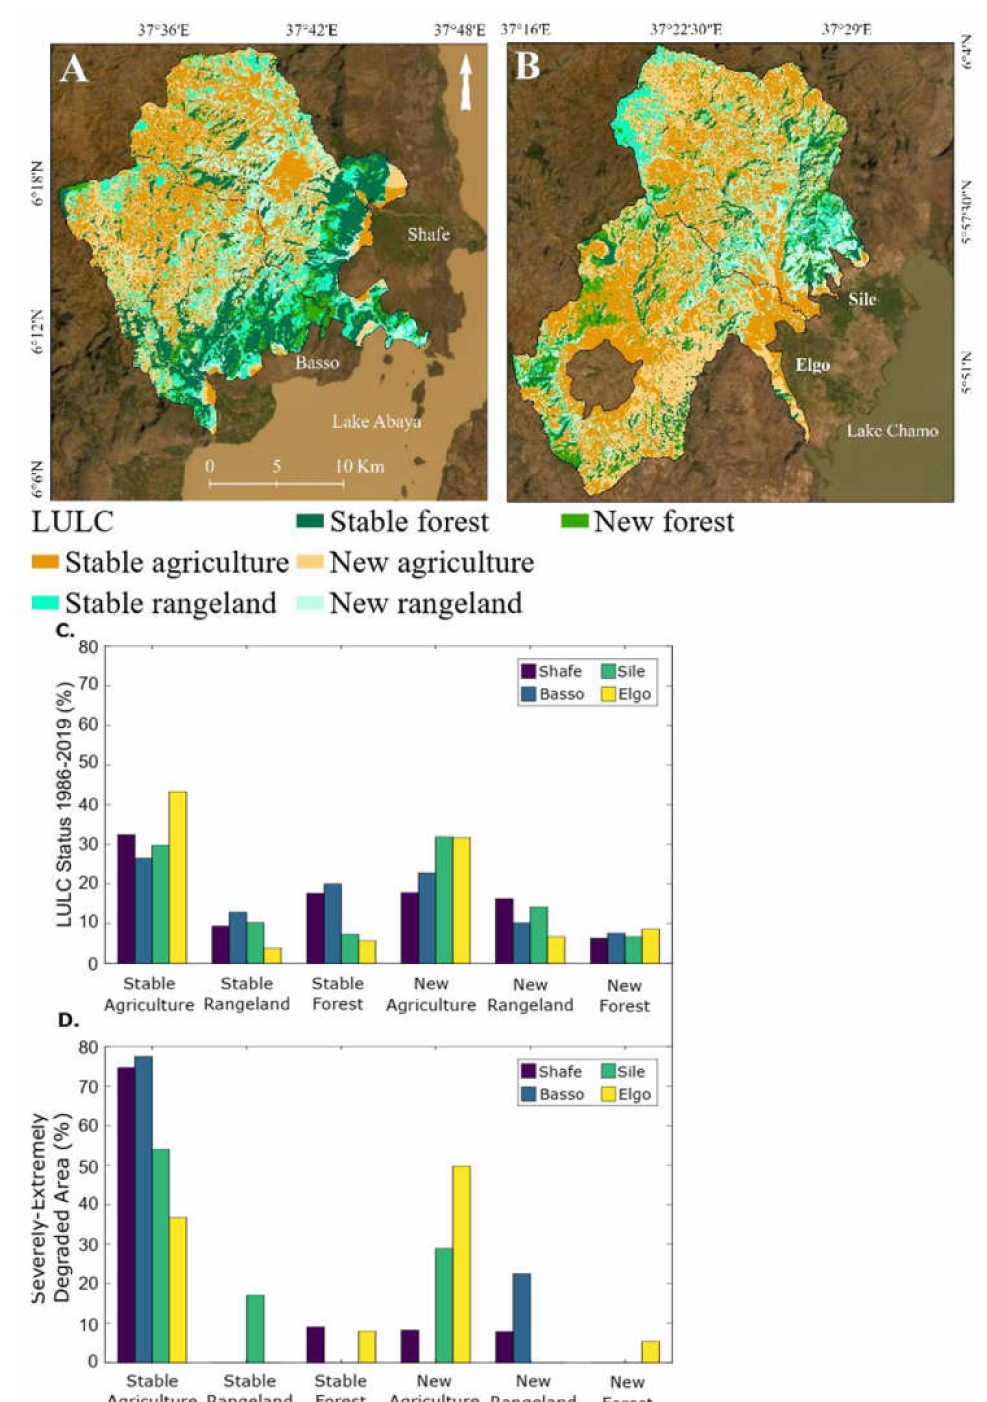
Figure 9. Relationship between LULC dynamics over the 1986–2019 period and severity of degraded area based on GLD (i.e., GLD > 1 km km − 2 ) for each study catchment. ( A ) LULC dynamics of Shafe and Basso, and ( B ) Sile and Elgo catchments. ( C ) Percentage of each LULC that remained unchanged or that was gained for each catchment. ( D ) Percentage of area covered by severe to extreme degrada- tion for each LULC using active gullies. Most of the severely and extremely degraded sub-catchments of Shafe and Basso, and all sub-catchments of Sile and Elgo are located in rejuvenated landscapes. A total of ~340,000 people were living in the area in 2020 [71], resulting in a high average population density (310 inhabitants km − 2 ) for a rural landscape. Higher